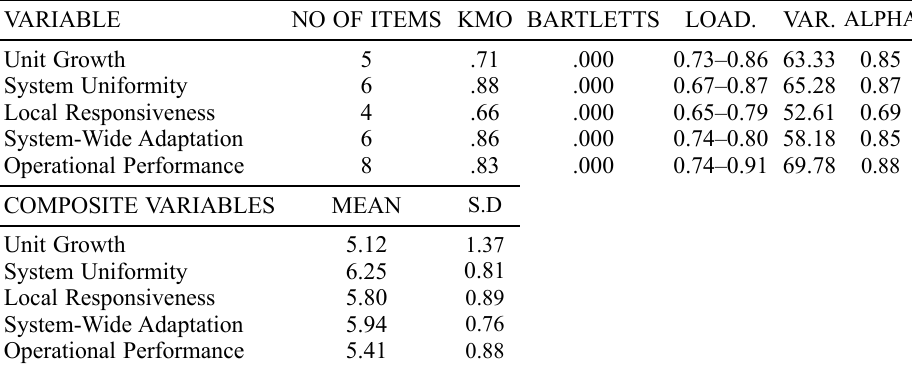
Table 3. Preliminary analysis of